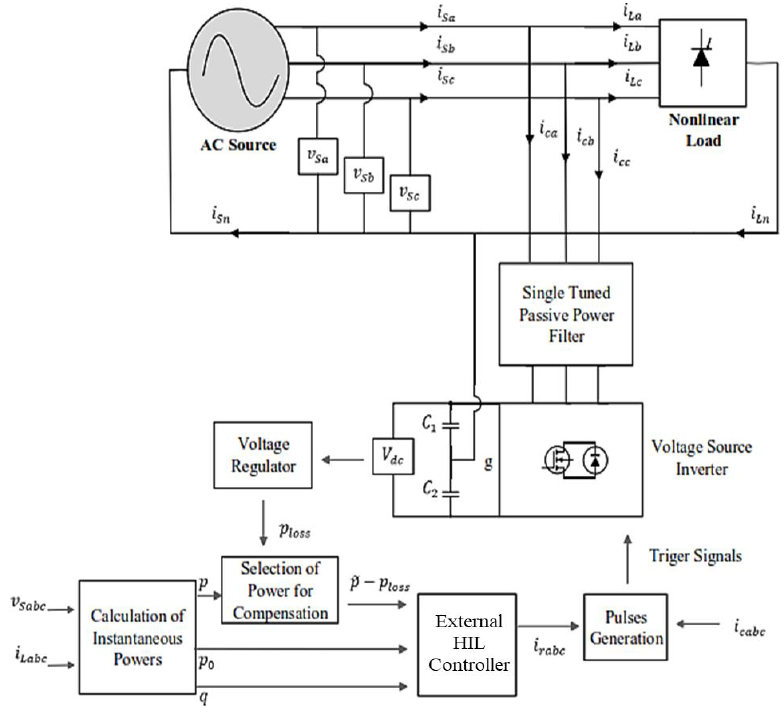
Figure 1. Block Diagram of the System Architecture.